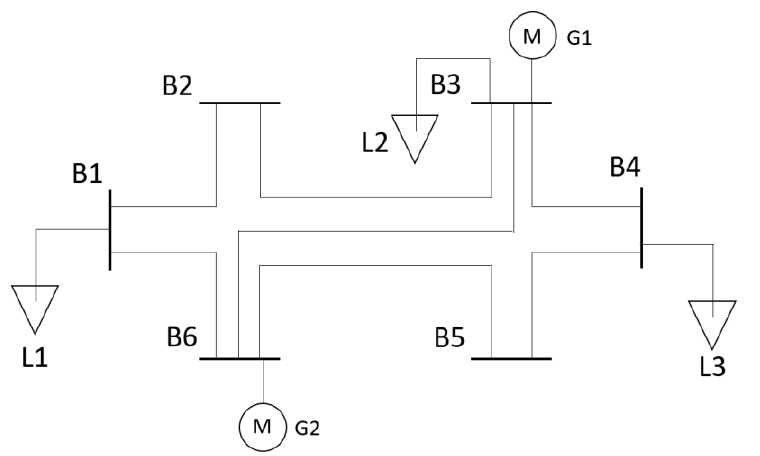
Figure 7. The 6-Bus System used in the numerical study. (B stands for bus, L stands for load, and G stands for generator)